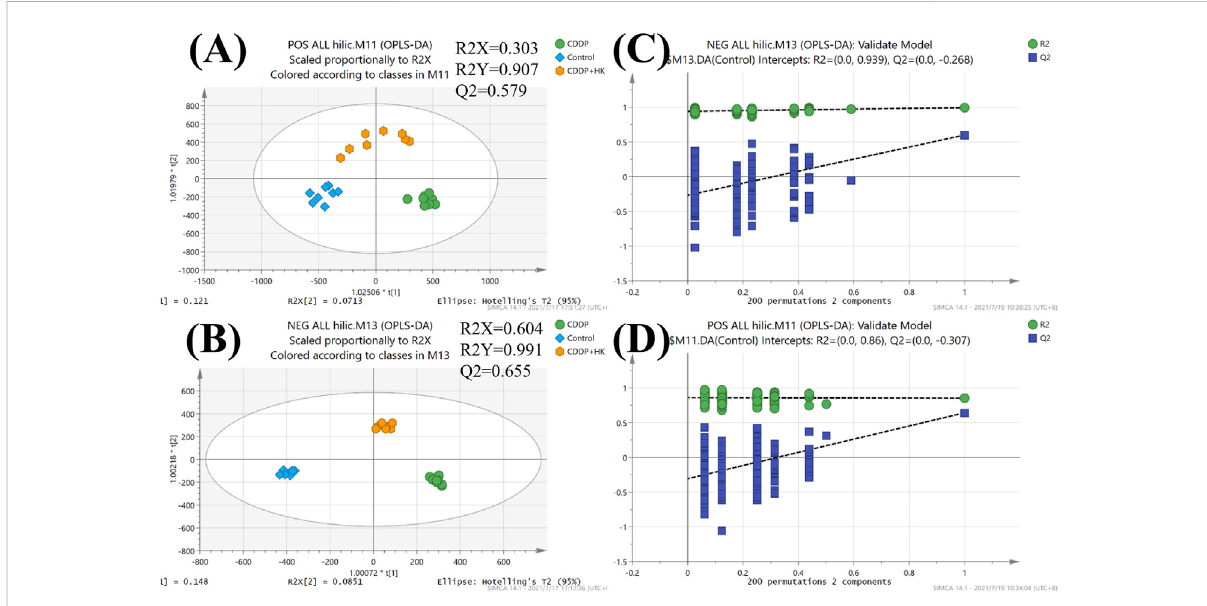
FIGURE 3 OPLS-DA score plots and permutation tests of urine from Control, CDDP, and CDDP + HK groups for HILIC-TOFMS analysis. (A) OPLS-DA score plots in positive mode; (B) OPLS-DA score plots in negative mode; (C) Permutation tests in positive mode; (D) Permutation tests in negative mode.